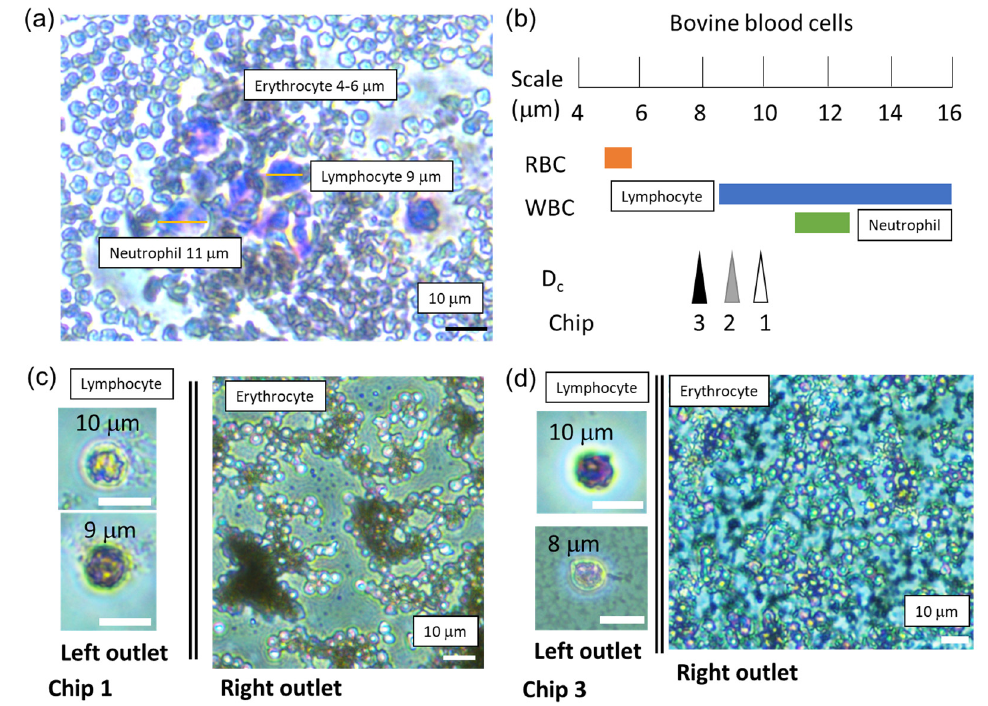
Figure 5. ( a ) A microscopic image of bovine blood cells before sorting. ( b ) Comparison of the diameters of bovine blood cells [29–32] and D c values of the microfluidic DLD devices. Microscopic images of bovine blood cells collected at the left and right outlets using ( c ) Chip 1 and ( d ) Chip 3, respectively. The scale bars are 10 μm.